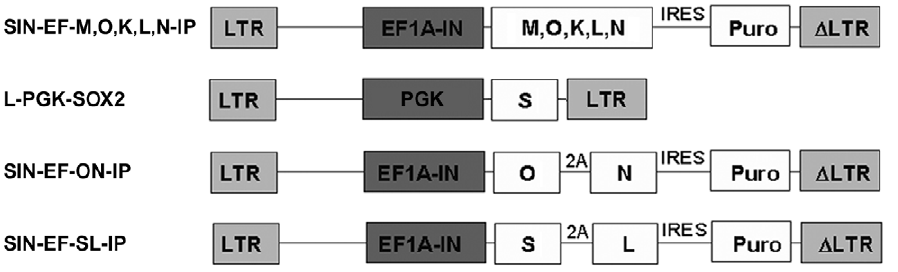
Figure 1. Lentiviral vectors used in IPSC production. LTR: viral LTRS, EF1A-IN: elongation factor 1-alpha promoter, PGK: PGK promoter, M: cMyc, O: Oct4, S: Sox2, K: KLF4, L: Lin28, N: Nanog transgenes. 2A: translation interruption element, IRES: internal ribosomal entry site, Puro: puromycin resistance gene.